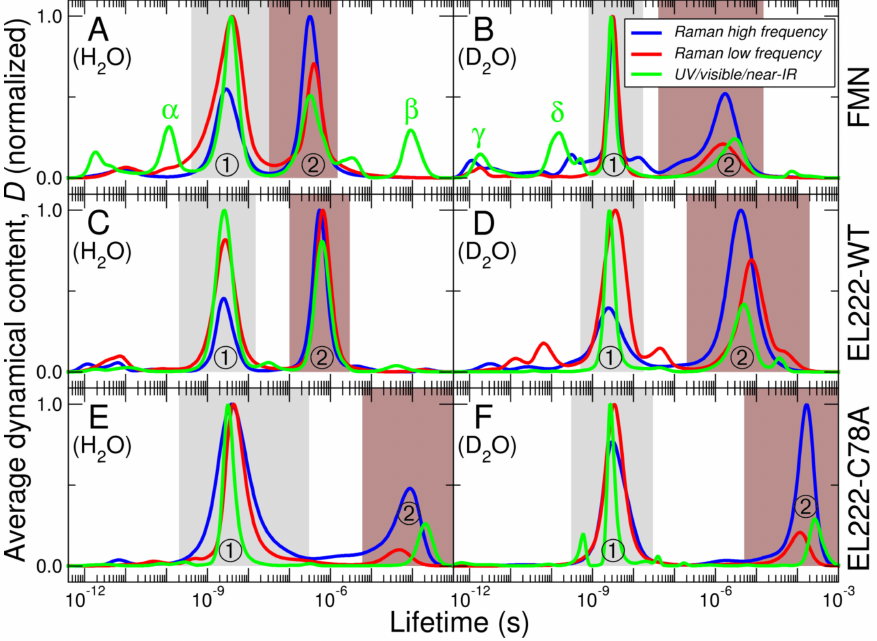
Figure 4. Normalized average dynamical content ( D ) as a function of lifetime. ( A ) FMN in H 2 O. ( B ) FMN in D 2 O. ( C ) EL222-WT in H 2 O. ( D ) EL222-WT in D 2 O. ( E ) EL222-C78A in H 2 O. ( F ) EL222- C78A in D 2 O. The curves have been calculated from the lifetime density plots shown in Figures S4–S6, by averaging over three spectral regions: Raman high frequency (1750–1000 cm − 1 , blue lines), Raman low frequency (1000–303 cm − 1 , red lines), and UV/visible/near-IR (380–1000 nm, green lines). The two most abundant events present at all probed frequencies are labeled as 1 (cid:13) (gray background) and 2 (cid:13) (brown background). Extra dynamical events found at some but not all frequency ranges are labeled with Greek letters ( α , β , γ , and δ ). Table 1. Mean lifetimes obtained from lifetime distribution analysis using the maximum entropy method. The units are indicated in the penultimate column (scale). A plausible interpretation for the observed lifetimes is indicated in the last